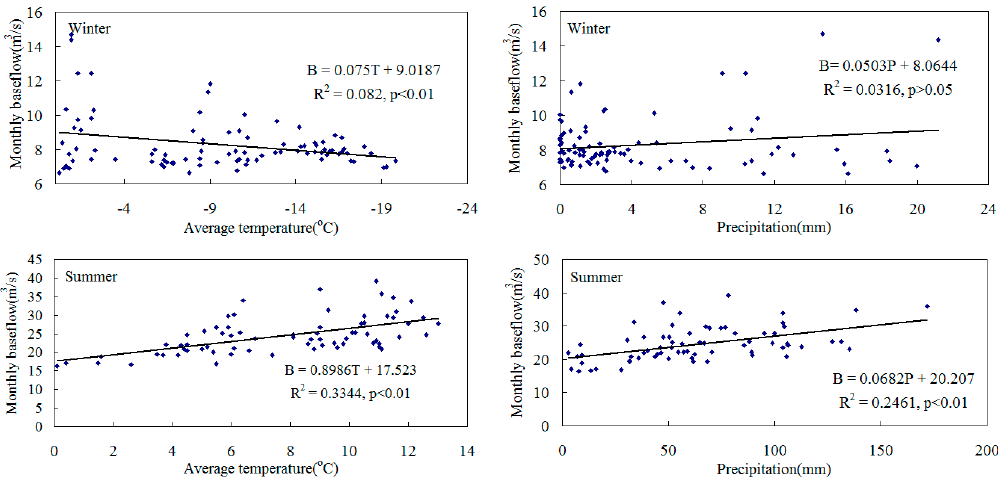
Figure 10. Monthly precipitation (P) and average temperature (T) plotted against baseflow (B) in the summer/winter half of the year, during 1996–2009.